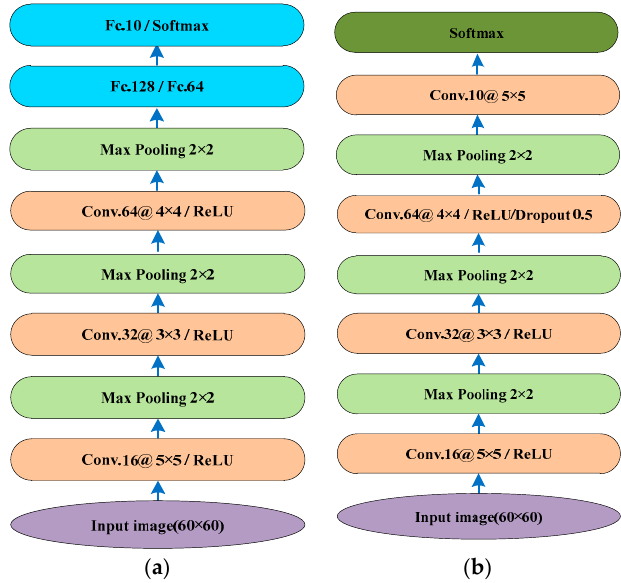
Figure 8. Optimal structures of traditional CNN ( a ) and A-convnet ( b ) for the 60 × 60 input image.